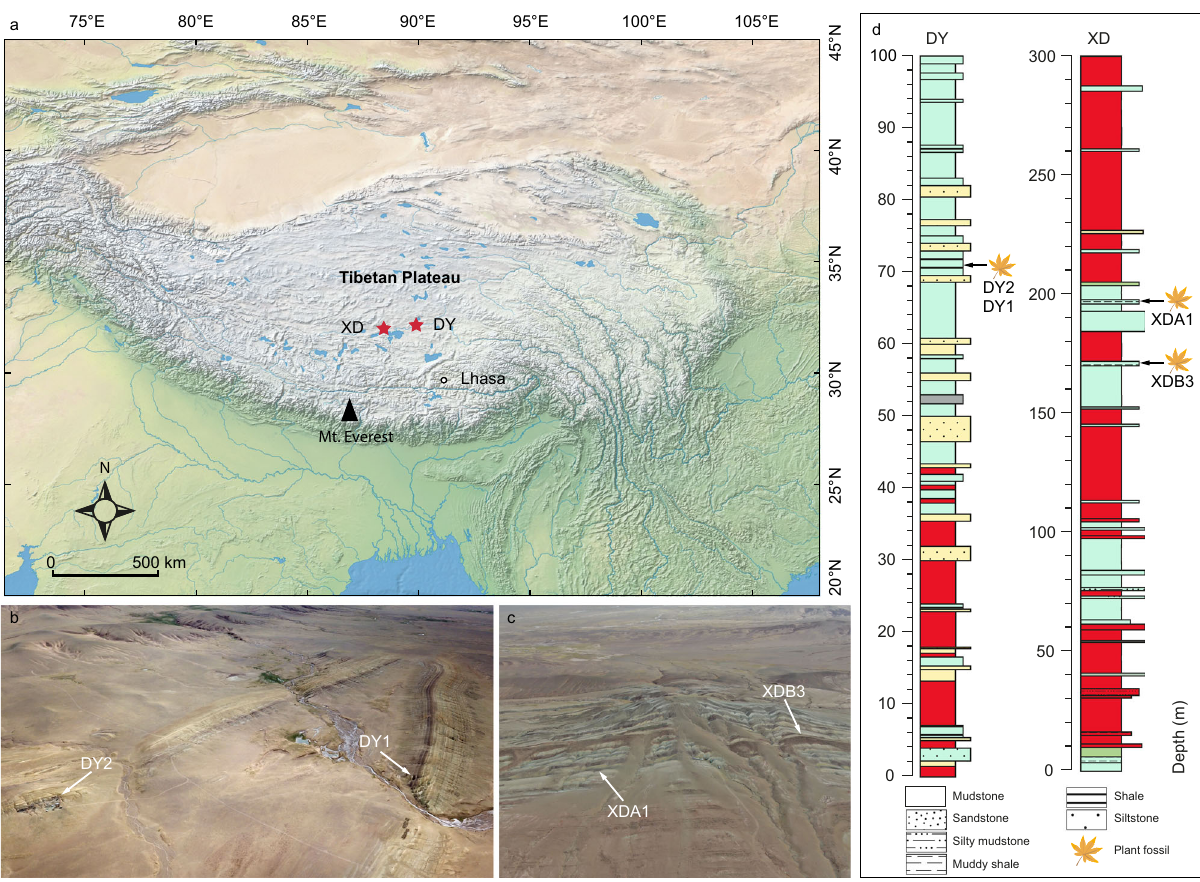
Fig. 1 The location of two fossil sites from the early late Eocene of central Tibetan Plateau, China. a Map showing the fossil sites (red stars) from the middle member of the Niubao Formation, central Tibetan Plateau. The base map was downloaded from Natural Earth (https://www.naturalearthdata.com/). XD, the site in Xiede village; DY, the site in Dayu village. b , c Outcrop drone images of fossil sites near Dayu 51 and Xiede villages. d The stratigraphy of Dayu 51 and Xiede sections. The colour of each layer re fl ects the colour of the